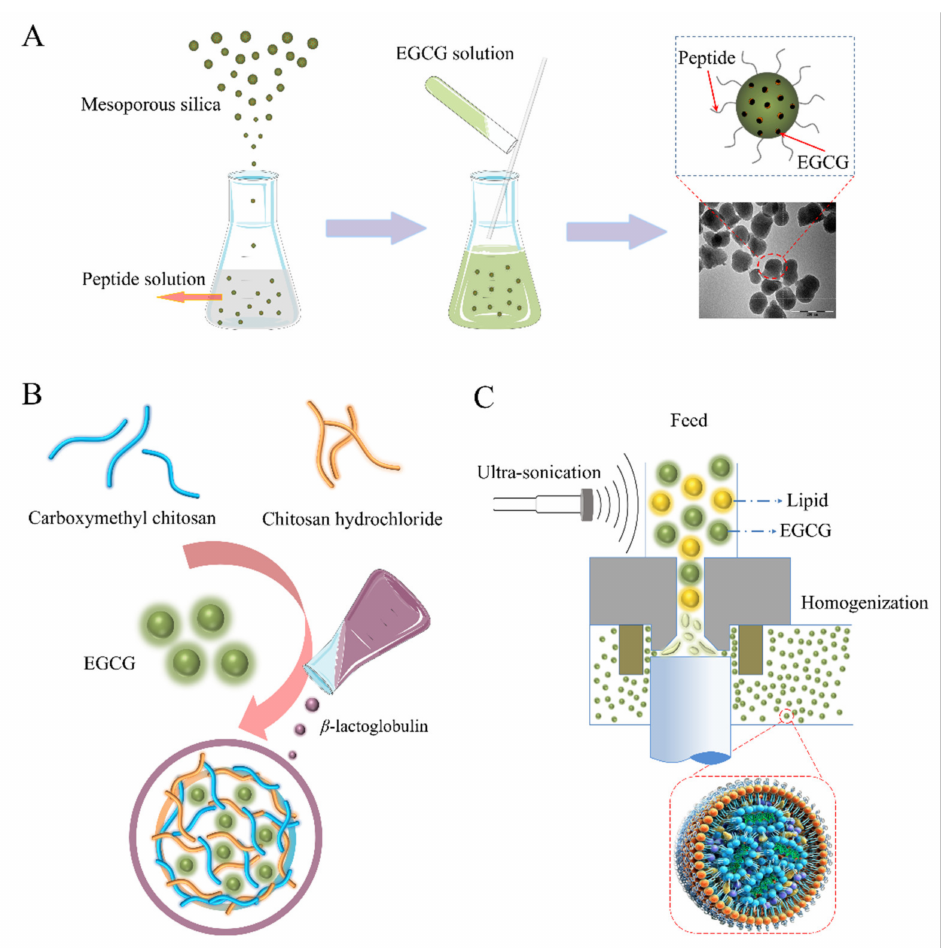
Figure 4. ( A ) The loading of EGCG into nanoparticle carriers functionalized with the shell-core struc- ture. Reproduced with permission [54], Copyright © 2015, American Chemical Society. ( B ) Schematic illustration of the encapsulation of EGCG by PNPs with double-wall structure. ( C ) Nano-lipids prepared by sonication and homogenization for enhanced stability and bioavailability of